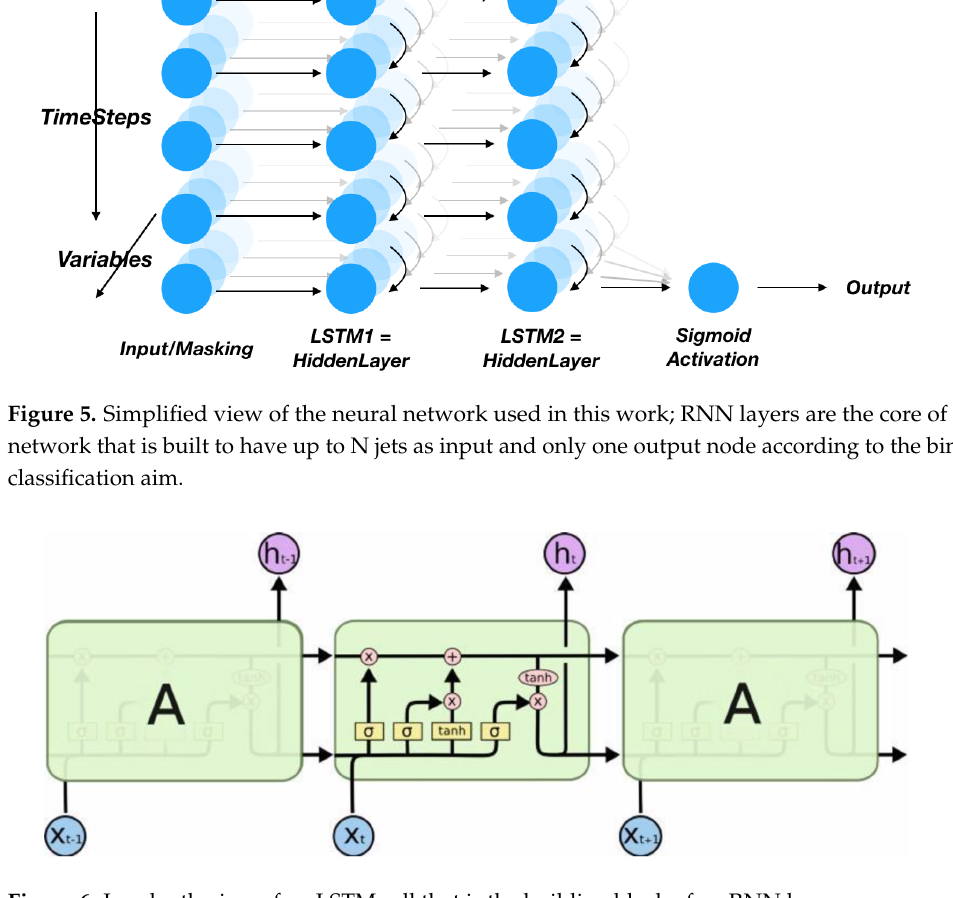
Figure 6. In depth view of an LSTM cell that is the building block of an RNN −